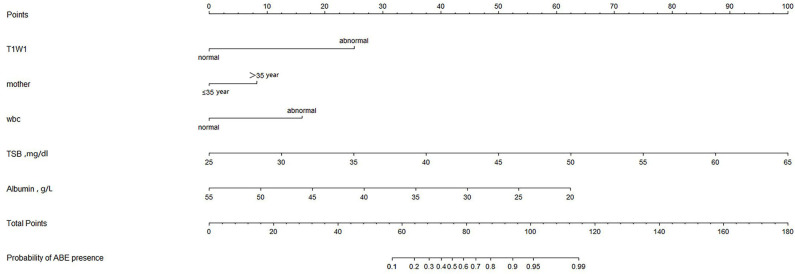
Nomogram of ABE Presence.